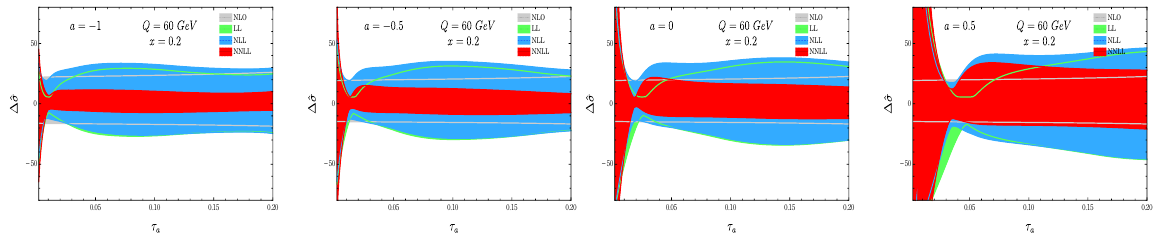
Figure 4 . Relative perturbative uncertainty in the differential cross-section for different a = − 1 , − 0 . 5 , 0 , and 0 . 5